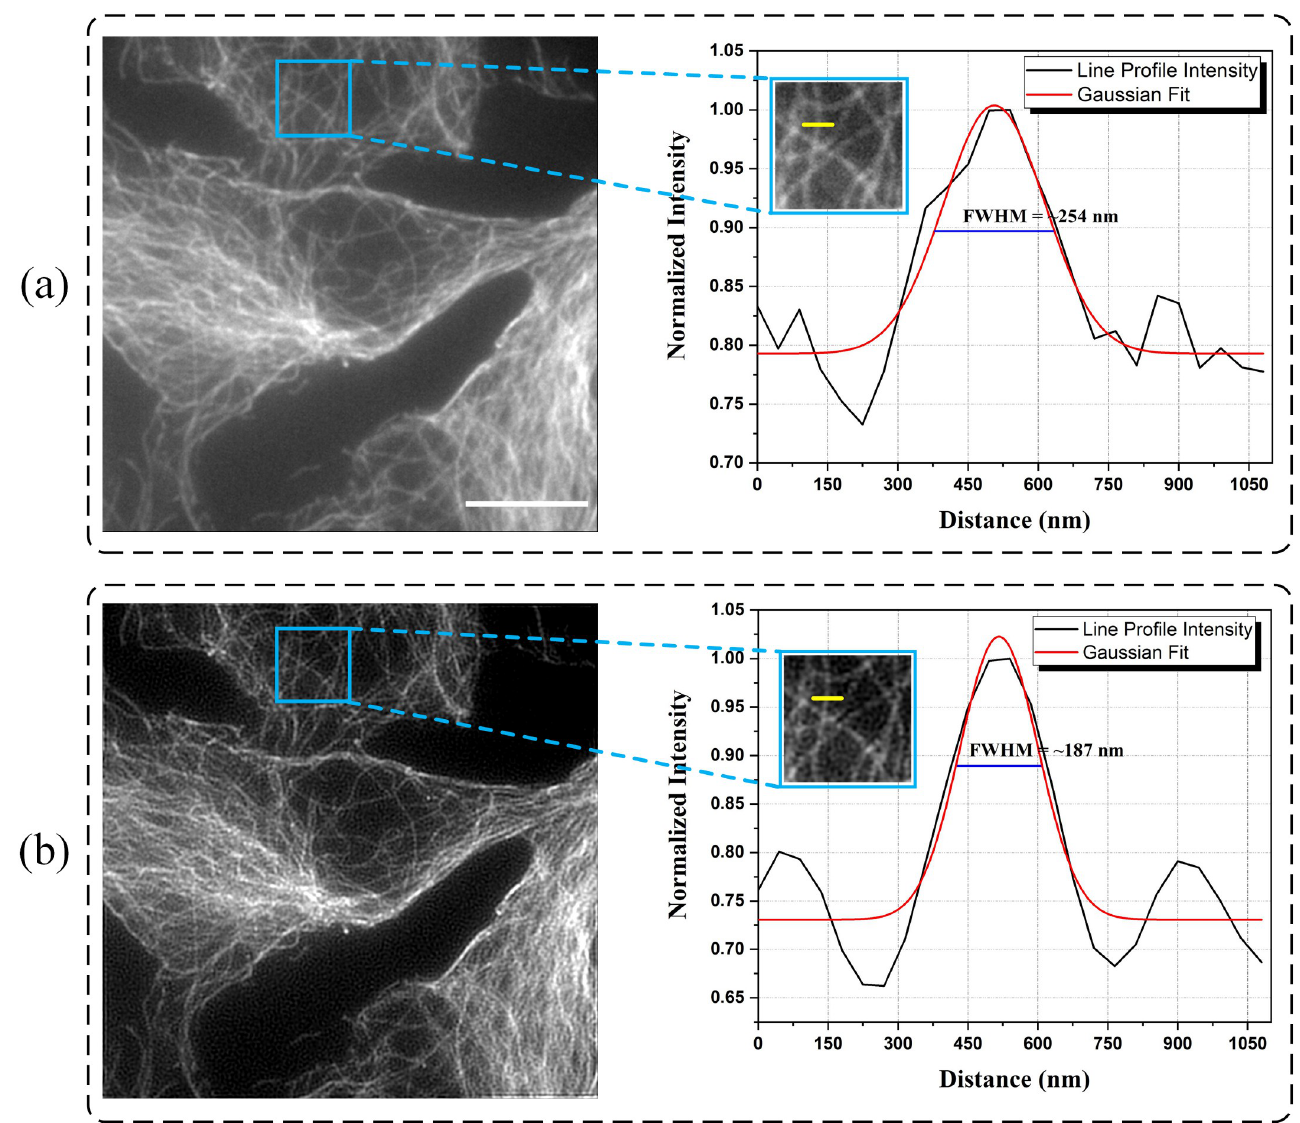
Fig 11. Cos7 cells were labelled for tubulin (Alexa Fluor 488). Microtubule images obtained with (a) wide-field illumination and (b) SIM reconstruction together with line profiles in selected regions. Line profiles were plotted along yellow lines presented in the insets. Scale bar indicates 10 μ